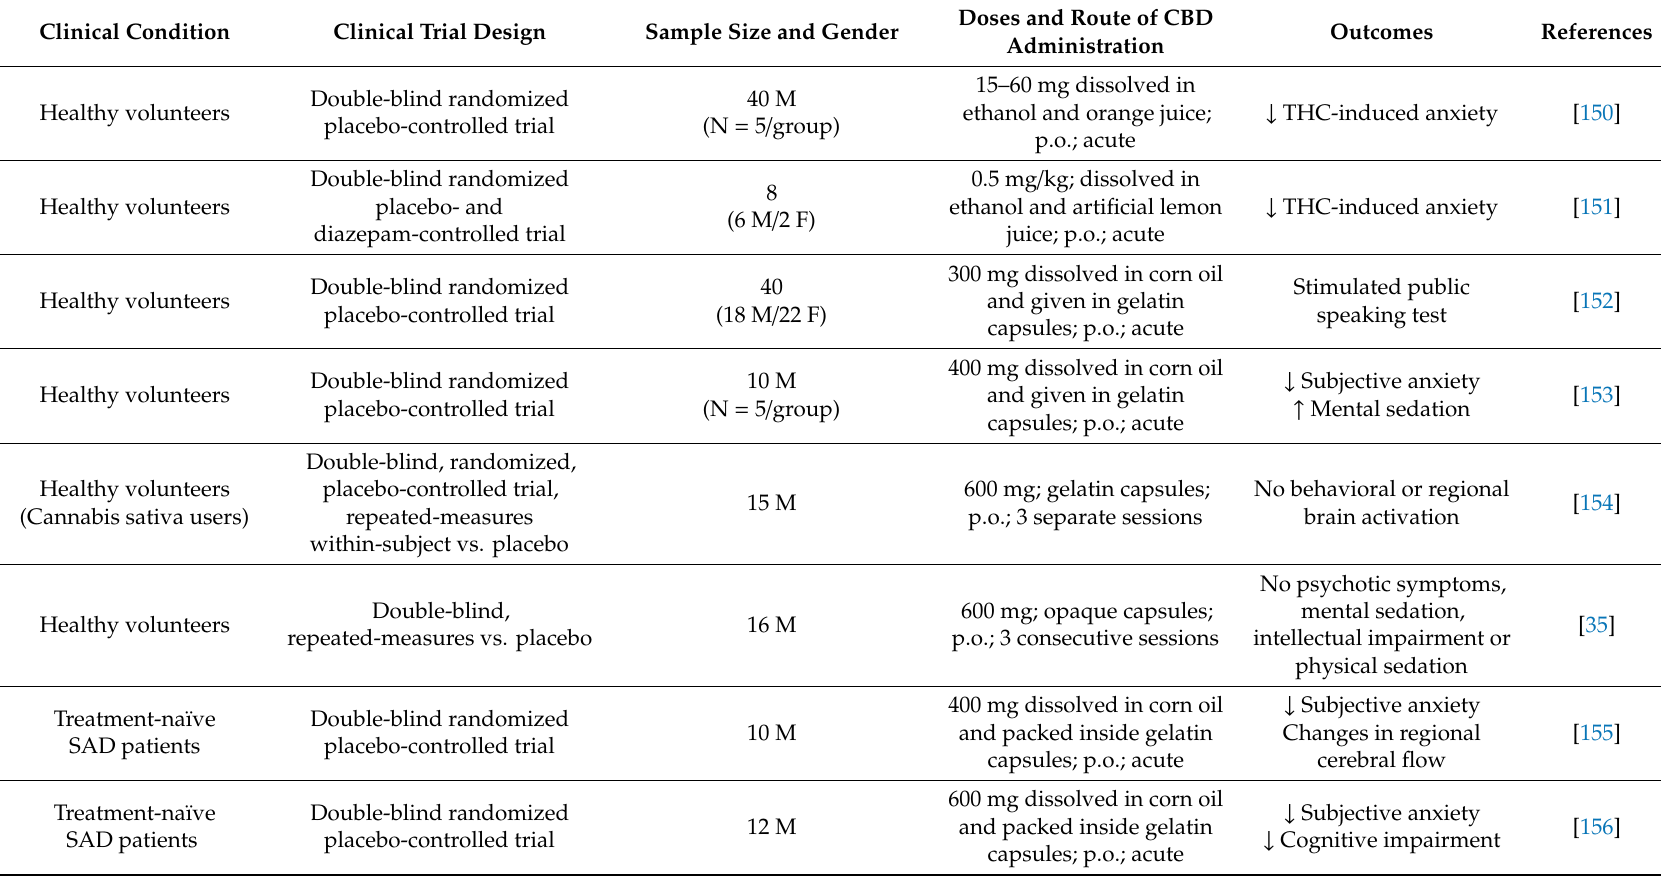
Table 3. Main outcomes achieved from clinical trials of CBD for anxiety, PTSD and depressive